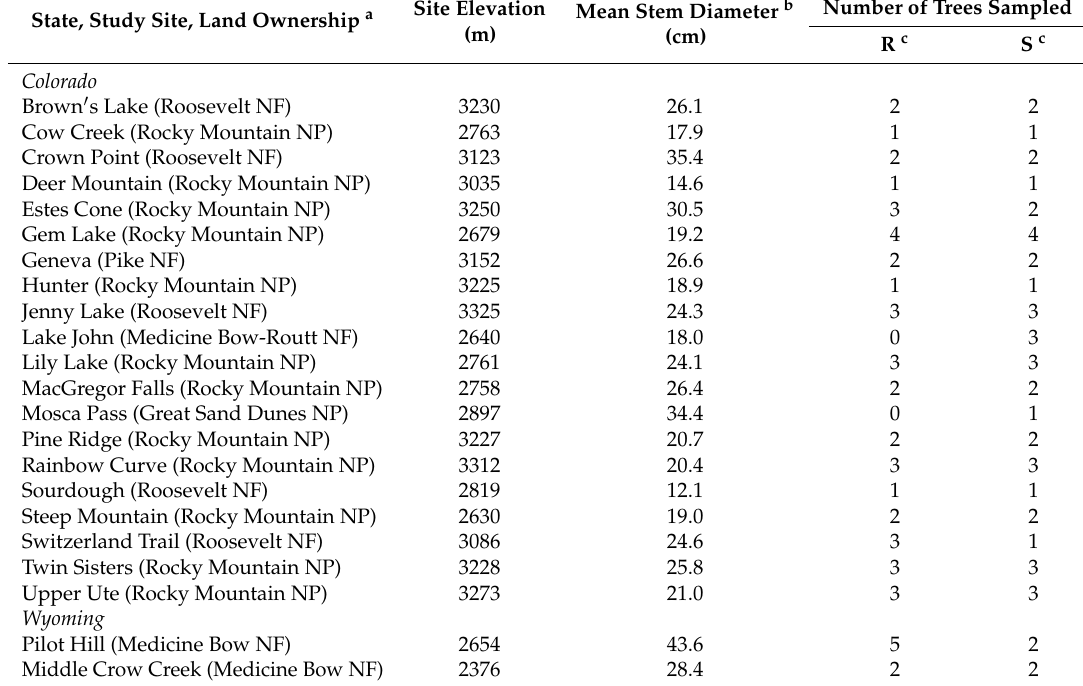
Table 1. Limber pine sites and trees sampled for core extraction in the Southern Rocky